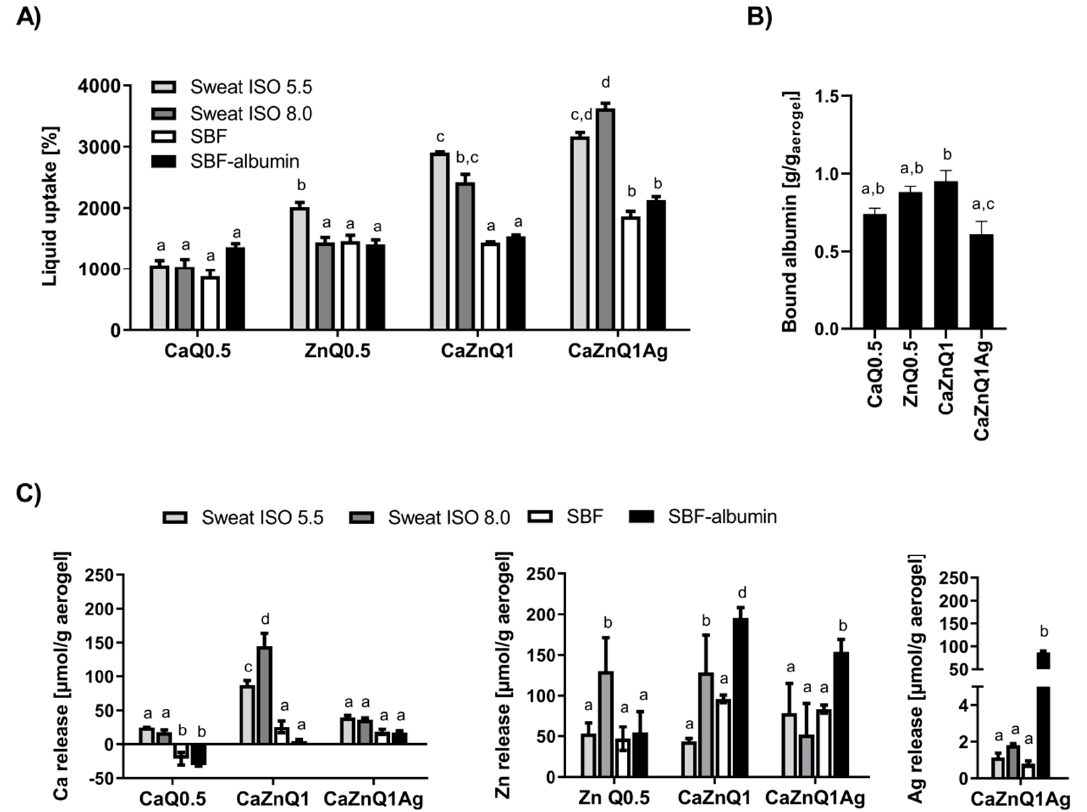
Figure 1. Swelling behavior and metal release of alginate-based aerogels in substitutes for human body fluids. Aerogels were incubated for 5 min in the body fluid substitutes before quantification of ( A ) liquid uptake ( B ) albumin binding and ( C ) metal release. Data are presented as means ± SEM of three independent experiments. Bars sharing letters are not significantly different (repeated measures ANOVA with Tukey’s multiple comparisons post-hoc test).